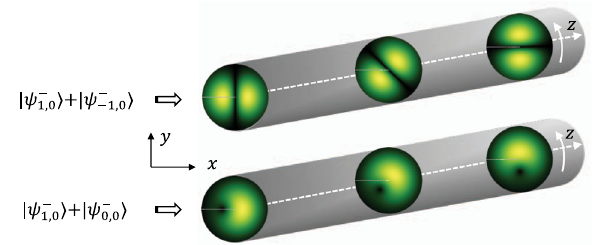
Fig. 2 Faraday effects. Propagation of the interference patterns of i þ j ψ (cid:3) i ) and OAM-unbalanced ( the OAM-balanced ( j ψ (cid:3) (cid:3) 1 ; 0 1 ; 0 i þ j ψ (cid:3) i ) superpositions along a AFM waveguide with the j ψ (cid:3) 1 ; 0 0 ; 0 interfacial-induced DMI.